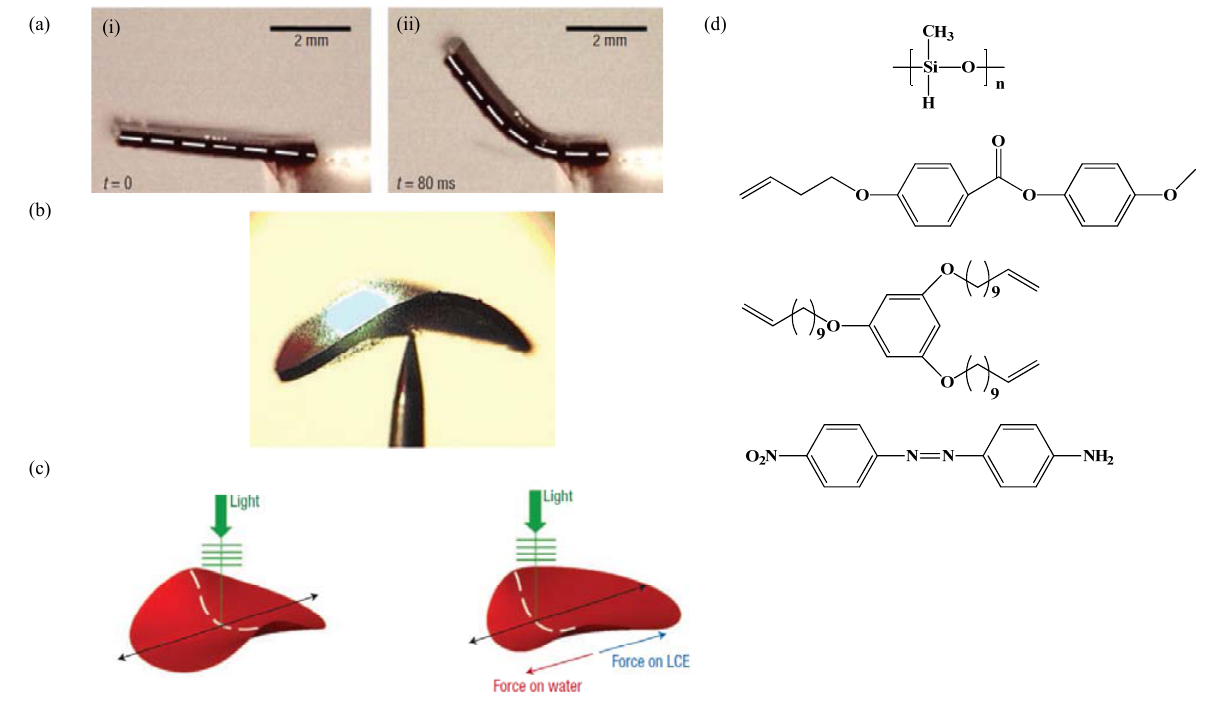
Figure 14. ( a ) Photo-mechanical response of the dye-doped LCE film, (i) before irradiation with 514 nm green laser, (ii) after illumination the sample bends about 45°. ( b ) The shape deformation of the dye-doped LCE sample on irradiation with 514 nm